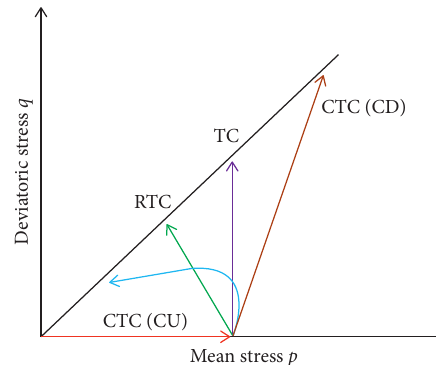
Figure 3: Loading stress path.